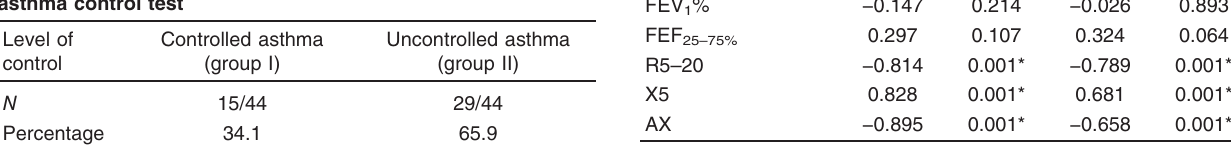
Table 2 Basic demographic data of patients in both groups Demographics Baseline spirometry